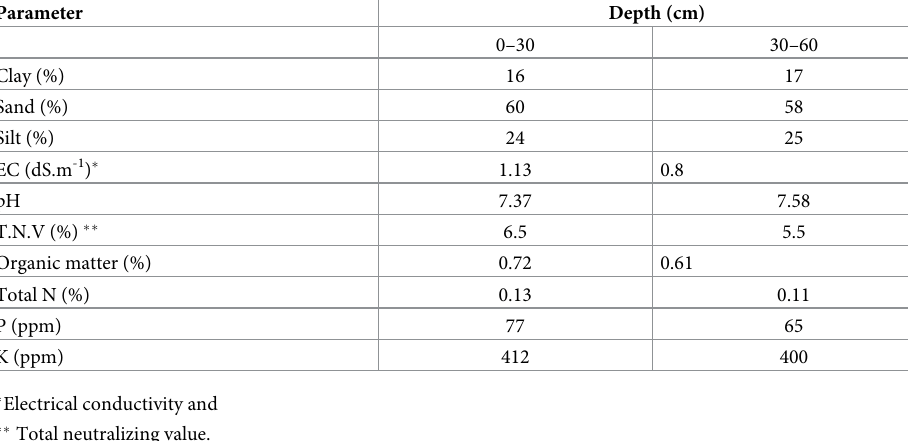
Table 1. Some physico-chemical properties of the research field